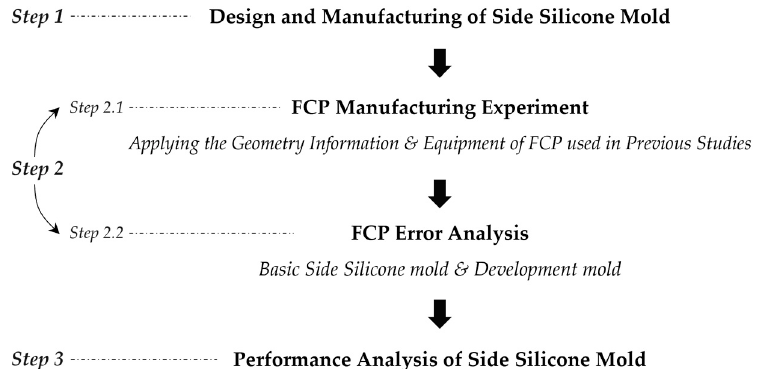
Figure 2. Research Flow.